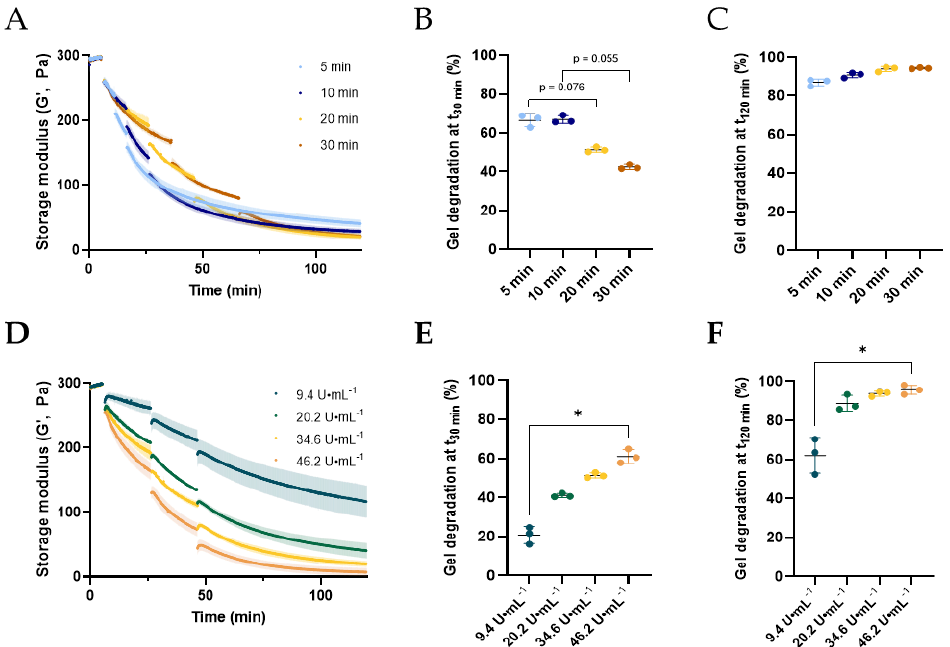
Figure 3. Refinement of PNT4 degradation parameters by triple injections of Hylenex, followed by rheological time sweeps. ( A ) Evolution of the storage modulus of PNT4 gels over time, measured by time sweeps (37 °C, strain 0.1%, 1 Hz), following triple injections of the Hylenex enzyme (34.6 U · mL − 1 ) with injection spans of 5, 10, 20, and 30 min, Percentage of gel degradation after 30 ( B ) or 120 ( C ) min for each injection span, compared to the initial storage modulus set at 300 Pa, ( D ) Evolution of the storage modulus of PNT4 gels over time, measured by time sweeps (37 °C, strain 0.1%, 1 Hz), following triple injections of the Hylenex enzyme 20 min apart, with enzymatic unit numbers of 9.4, 20.2, 34.6, and 46.2 units of HAase per mL of gel, percentage of gel degradation after 30 ( E ) or 120 ( F ) min for each enzymatic unit number, compared to the initial storage modulus set at 300 Pa. All results are presented as mean ± S.D, n = 3. Mann–Whitney non-parametric tests were performed on ( B , C , E , F ), with a confidence level α = 0.05 (* p < 0.05).